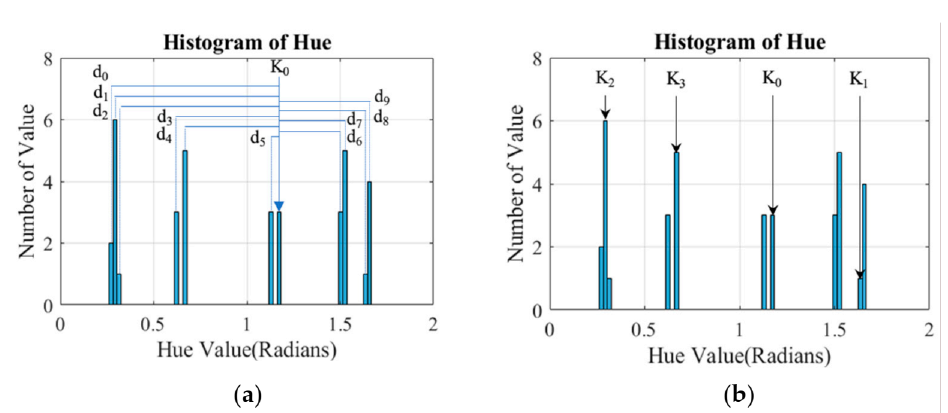
Figure 4. K means++ algorithm. ( a ) The distance between each pixel and the center point is determined; ( b ) Center values are determined after four repeated